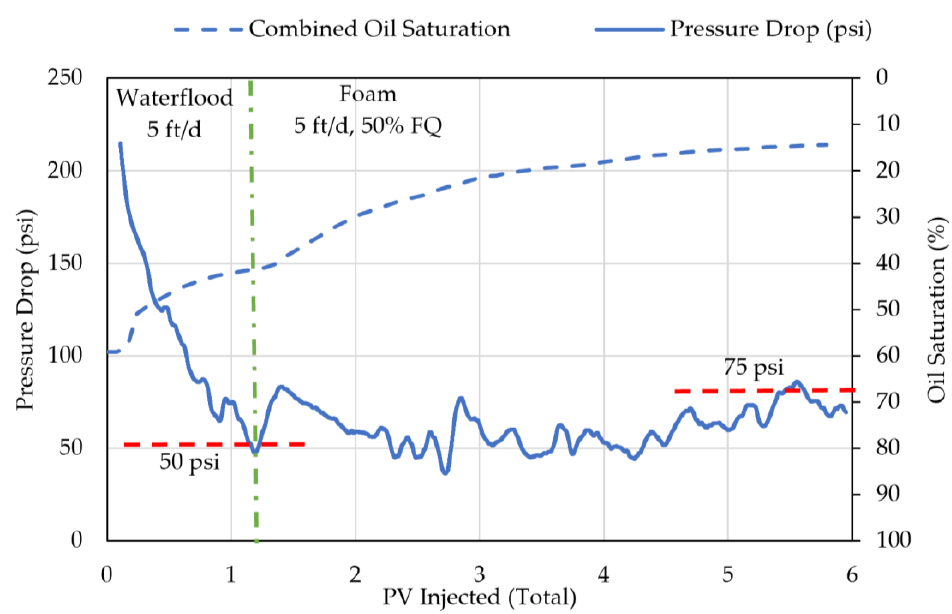
Figure 14. Pressure drop across both cores and the combined oil saturation for DI-Exp 3.